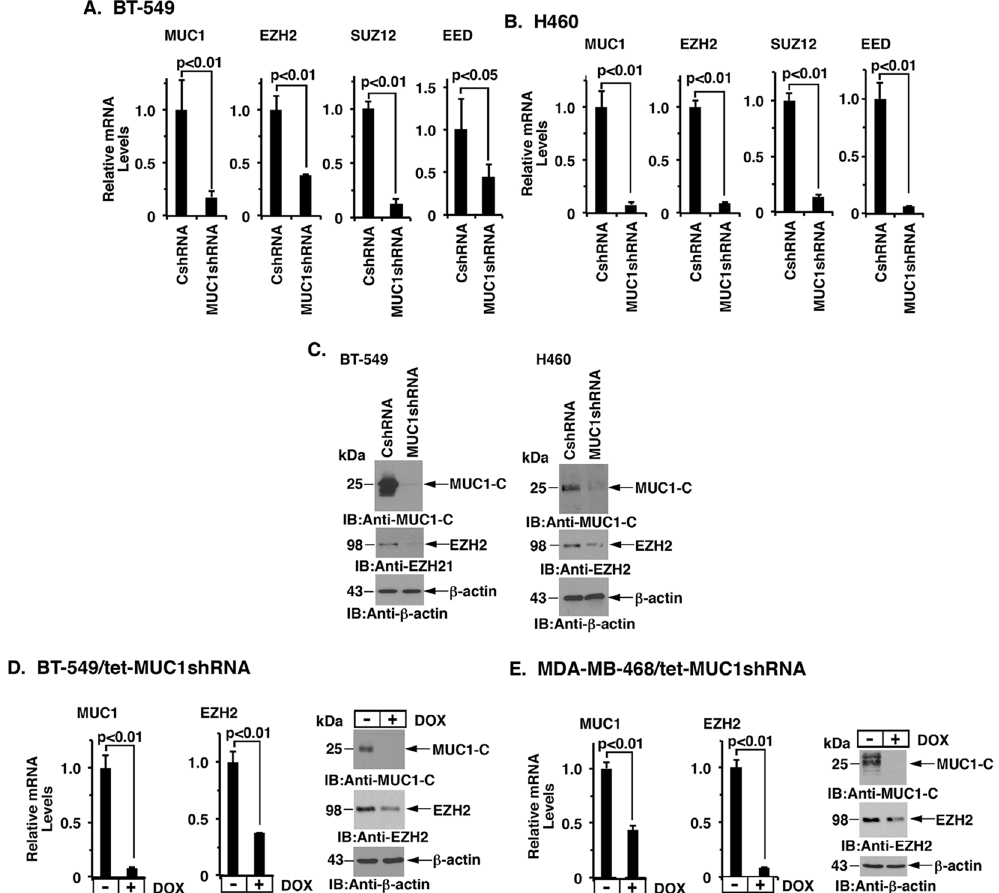
Figure 1. Silencing MUC1-C suppresses EZH2, SUZ12 and EED expression. A and B. BT-549 ( A ) and H460 ( B ) cells stably expressing a control scrambled shRNA (CshRNA) or a MUC1shRNA were analyzed for MUC1, EZH2, SUZ12 and EED mRNA levels by qRT-PCR using primers listed in Table S1. The results (mean ± SD) are expressed as relative mRNA levels compared to that obtained for the CshRNA cells (assigned a value of 1). ( C ) The respective BT-549 (left) and H460 (right) cells expressing a CshRNA or MUC1shRNA were immunoblotted with the indicated antibodies. ( D and E ) BT-549 ( D ) and MDA-MB-468 ( E ) cells were stably transduced to express a tetracycline-inducible MUC1 shRNA (tet-MUC1shRNA). Cells treated with 200 ng/ml DOX for 4 d were analyzed for MUC1 and EZH2 mRNA levels by qRT-PCR. The results (mean ± SD) are expressed as relative mRNA levels compared to that obtained for control DOX-untreated cells (assigned a value of 1) (left). Lysates from cells treated with 200 ng/ml DOX for 7 d were immunoblotted with the indicated antibodies (right). See also Fig.